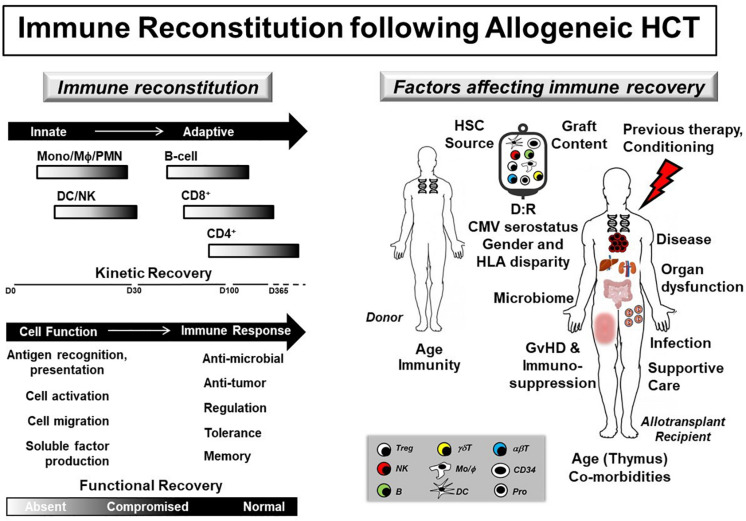
Immune reconstitution following allogeneic HCT. (Left panel) Immune reconstitution gradually recovers following allogeneic HCT with donor-derived innate immune cell numbers and function preceding adaptive immunity. (Right panel) Kinetic and functional immune recovery in the allogeneic HCT recipient are affected by donor (age, immune function), graft (HSC source, cell content), and recipient (age, presence of co-morbidities and thymic involution or damage, underlying disease and associated previous therapy, type of conditioning regimen, organ dysfunction, changes in microbiome, occurrence of GvHD and associated use of immunosuppression, infection and use of supportive care pharmaceutical agents) factors. In addition, disparities in donor (D) and recipient (R) CMV serostatus, gender and HLA matching also affect donor-derived immune recovery. Defects and delays in immune reconstitution strongly associate with decreased overall survival and increased transplant-related morbidity and mortality. αβT, alpha beta T cell; B, B-cell; CMV, cytomegalovirus; DC, dendritic cell; γδT, gamma delta T cell; GvHD, graft-versus-host disease; HLA, human leukocyte antigen; HSC, hematopoietic stem cell; MΦ, macrophage; Mono, monocyte; NK, natural killer; PMN, polymorphonuclear cell; Pro, progenitor cell; Treg, T regulatory cell.